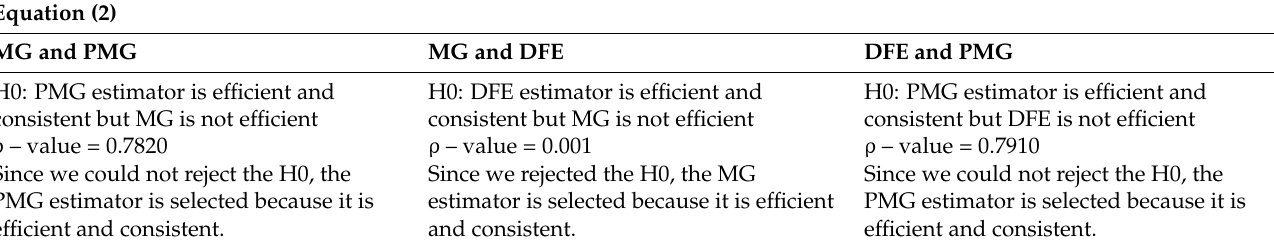
Table 13. Hausman tests for model 2.